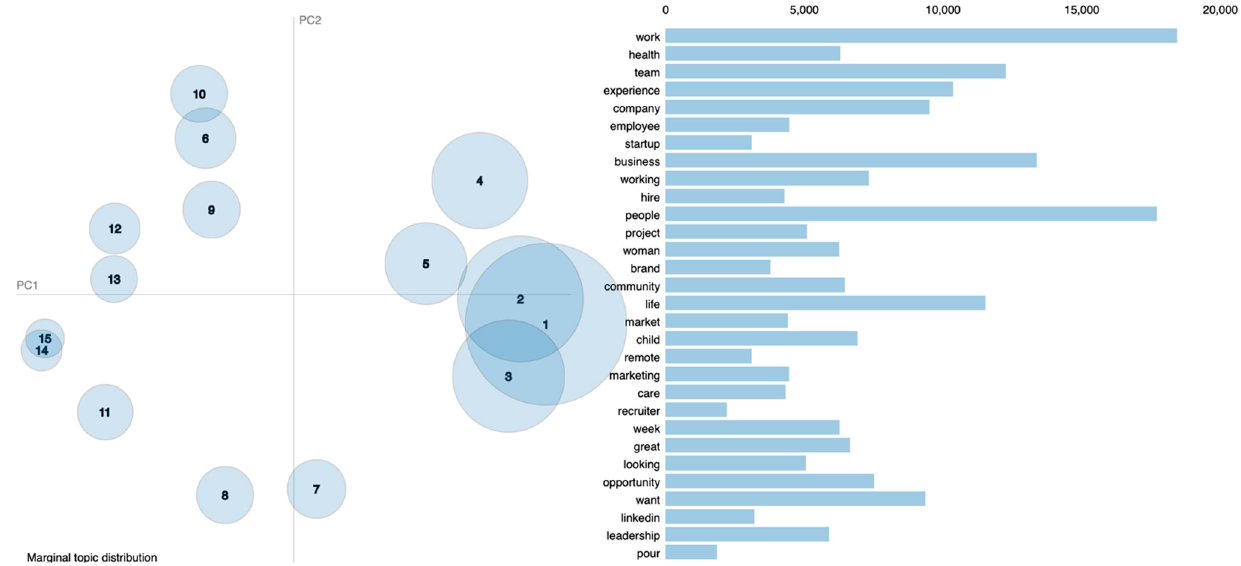
Figure 3. The intertopic distance map of the topics and the most important words.